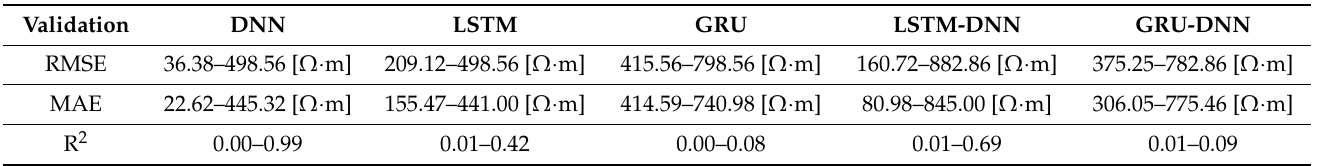
Table 2. Root mean square error (RMSE), mean absolute error (MAE), and coefficient of determination (R 2 ) based on various